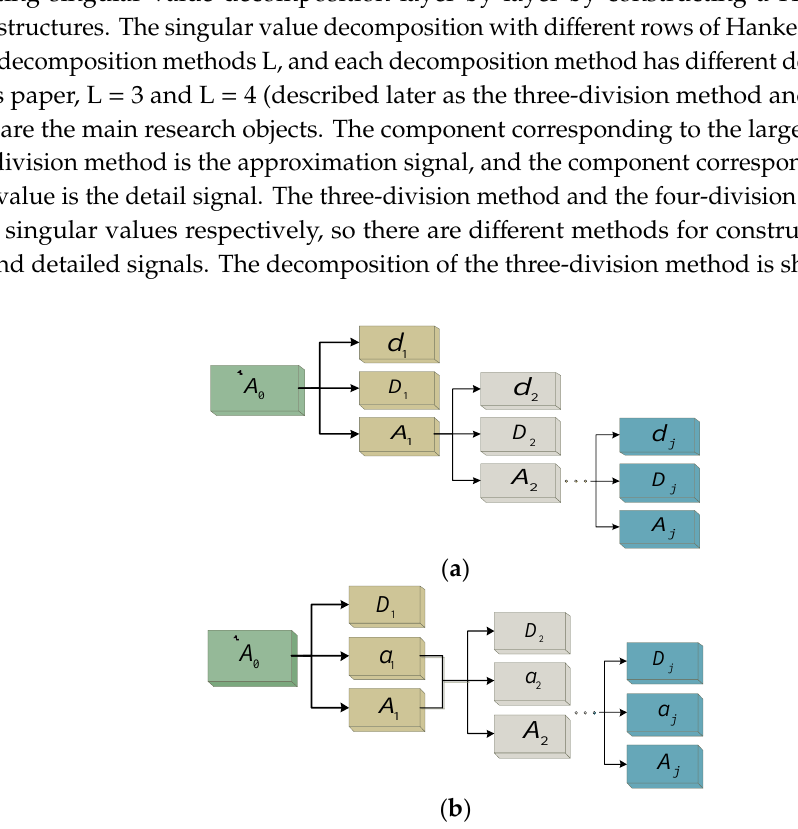
Figure 2. Schematic diagram of the decomposition of the three-division method. ( a ) N = 1, ( b ) N = 2.